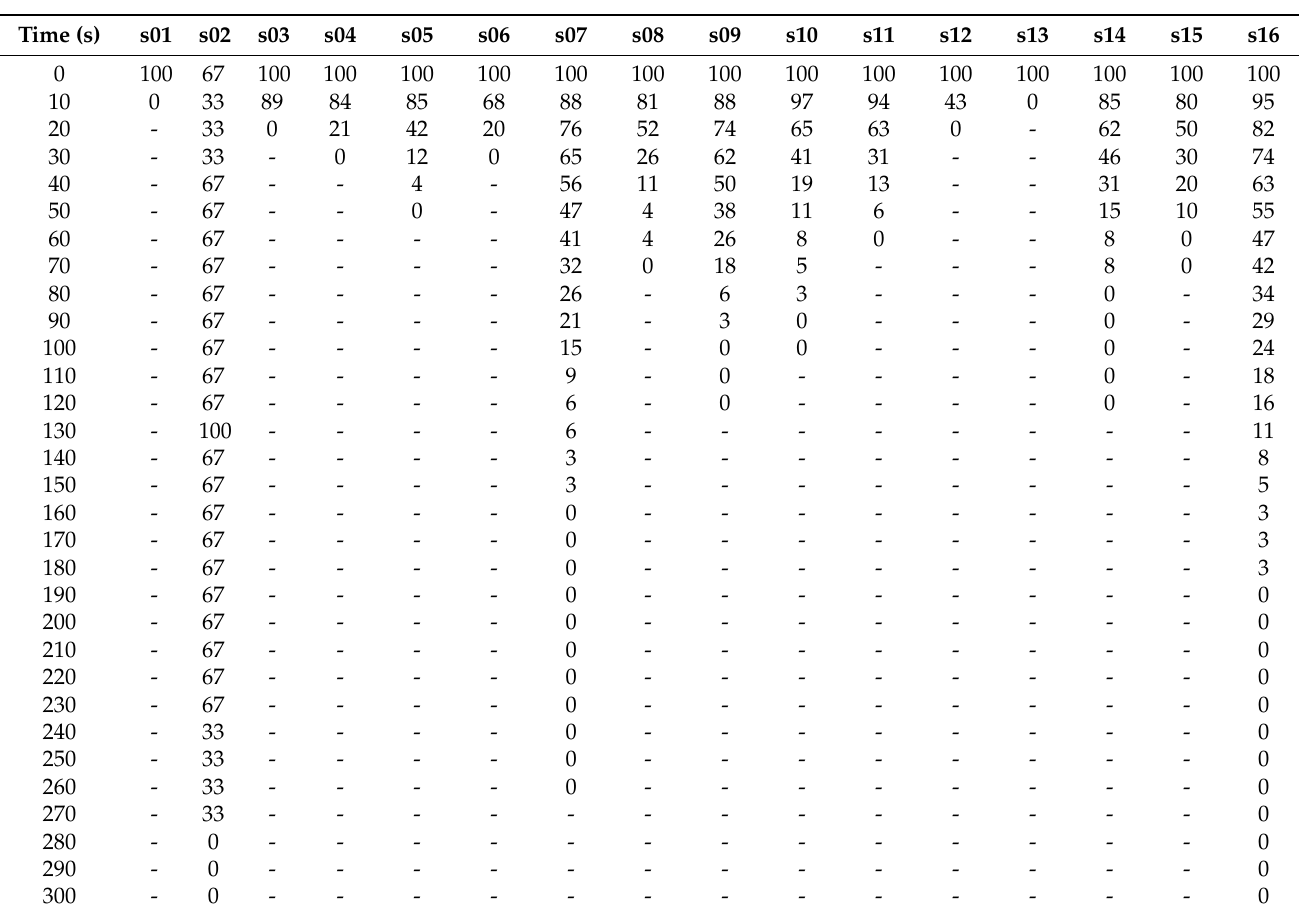
Table A2. Normalized distance of beer foam (%) from 3D camera for 16 beer